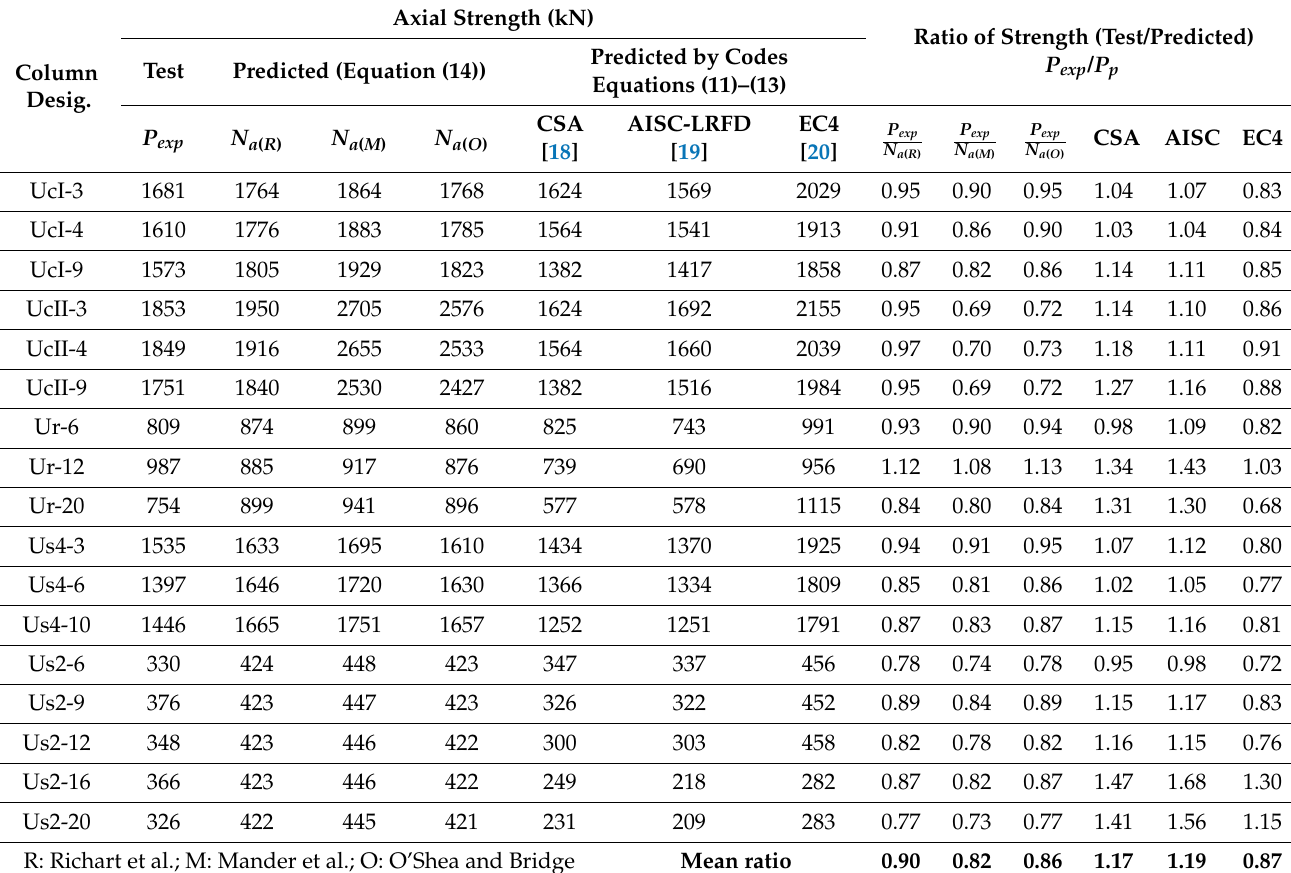
Table 6. Comparative study of strength prediction by analytical